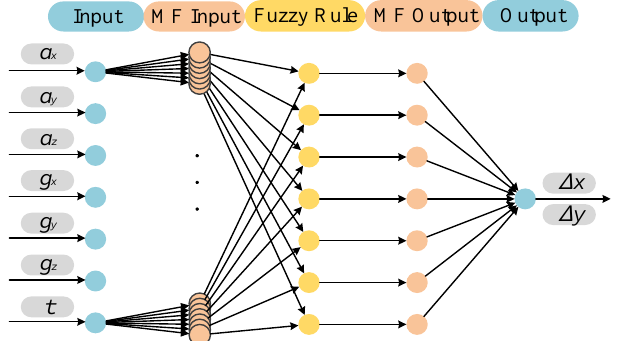
Figure 3. Network structure of ANFIS.